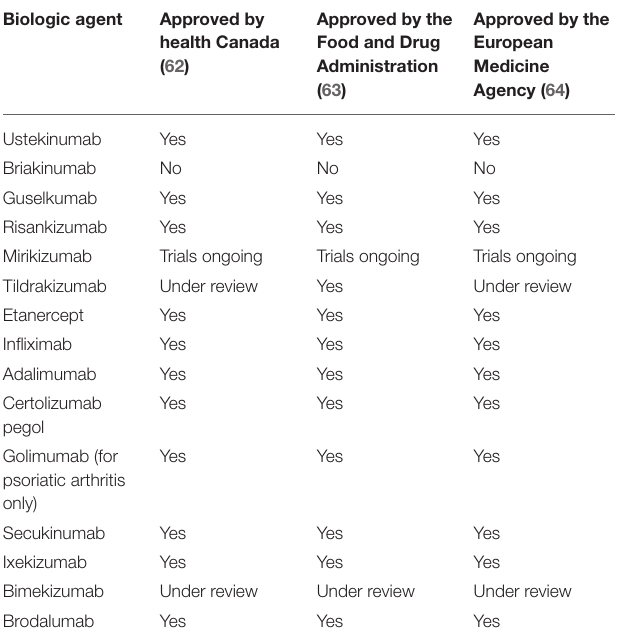
TABLE 1 | Summary of status of approval for the treatment of psoriasis by Health Canada, the Food and Drug Administration (FDA), and the European Medicines Agency (EMA) of biologic agents presented in this